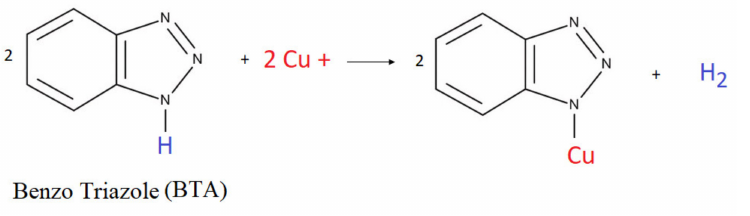
Figure 3. Mechanism reaction of the passivator (BTA) in the process of suppression of the corro- sion